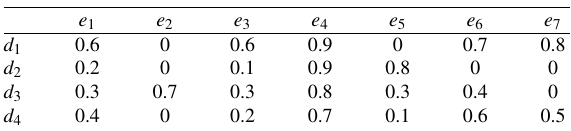
Table 16: Tabular representation of the fuzzy soft